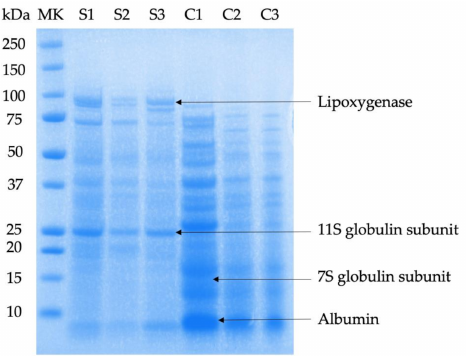
Figure 1. Representative SDS-PAGE gel of the samples studied. The left lane indicates molecular weight (KDa). MK—molecular markers; S1—split yellow pea raw soaking water; S2—split yellow pea spray-dried soaking water; S3—split yellow pea freeze-dried soaking water; C1—split yellow pea raw cooking water; C2—split yellow pea spray-dried cooking water; C3—split yellow pea freeze-dried cooking